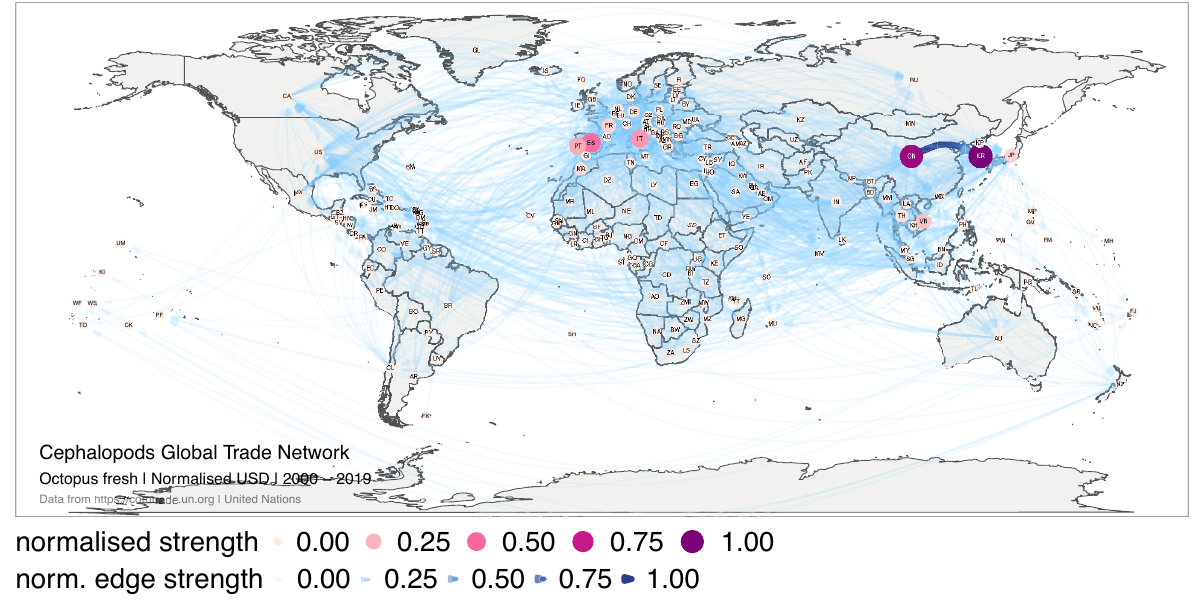
Figure 4. Global trade network for octopus live, fresh or chilled between 1 January 2000, and 31 December 2019 in monetary value (USD). The numbers correspond to the normalised strength for the monetary value. Each node represents a trader, and each edge represents the export–import relationship between two traders. The size and colour of the node represent the relative importance of the trader in the network in terms of its strength. The width and colour of the edge represent the relative importance of the relationship between two traders in terms of their edge strength. The figure was created with R 12 (https:// cran.r- proje ct. org) packages: “ggplot2” v.3.2.1 13 (https:// ggplo t2. tidyv erse. org), “ggmap” v.3.0.0 29 (https:// github. com/ dkahle/ ggmap) and